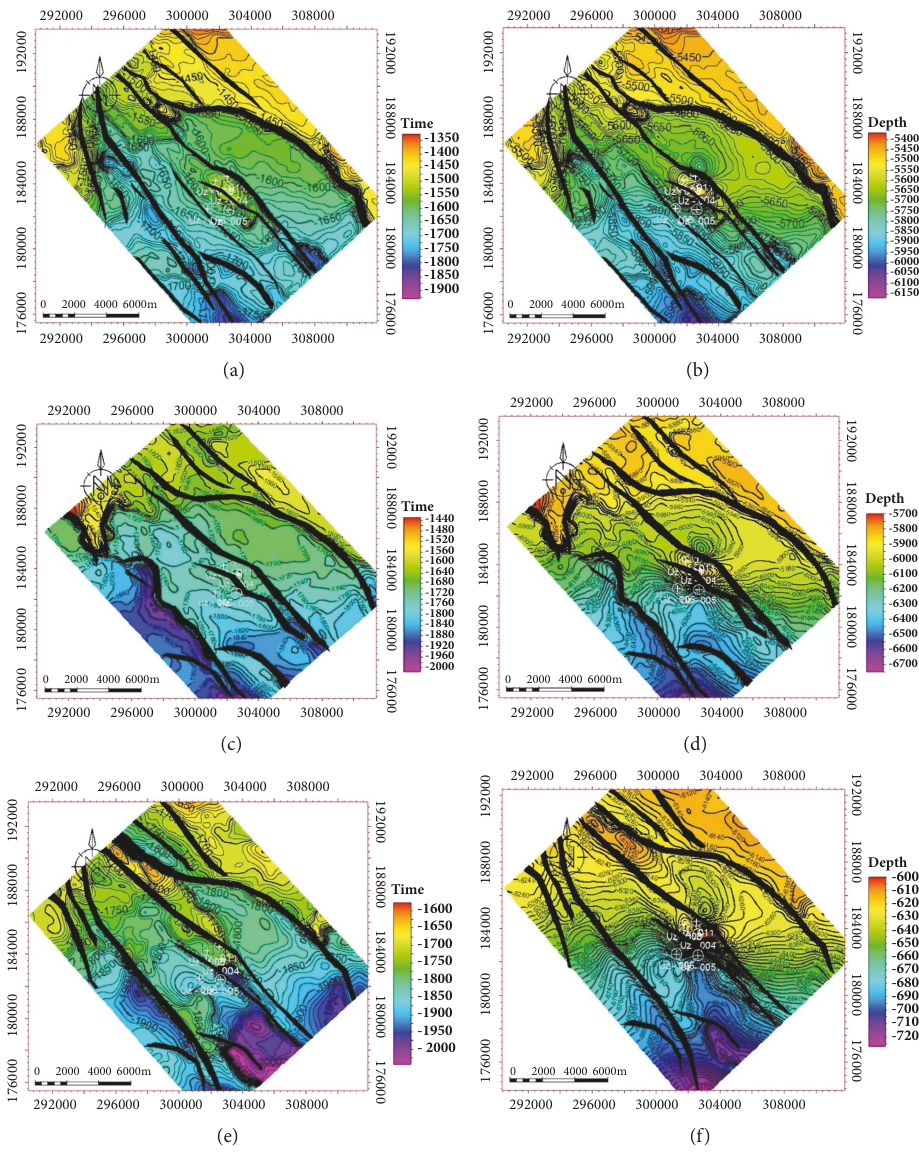
Figure 6: Structural time and depth maps of reservoirs. (a) Time structural map for D3100 reservoir top. (b) Depth structural map of D3100 reservoir top. (c) Time structural map for D5000 reservoir top. (d) Depth structural map of D5000 reservoir top. (e) Time structural map for D9000 reservoir top. (f) Depth structural map for D9000 reservoir